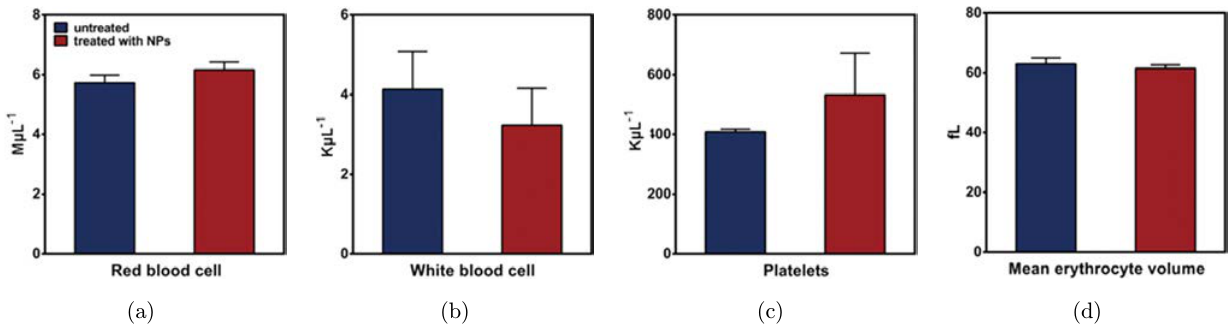
Fig. 6. Blood test results for rats treated with DCDPP-2TPA NPs and PBS (1 (cid:4) ) for 24 h. The red box represents the rats treated with DCDPP-2TPA NPs and the blue box represents the rats treated with PBS (1 (cid:4)